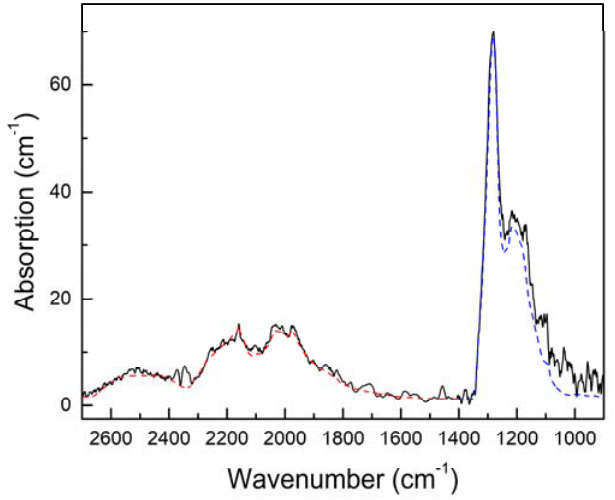
Figure 5. Infrared absorption spectrum of a spontaneous diamond aggregate from run ES-8. Red dashed curve shows standard absorption spectrum of type IIa diamond. Blue dashed curve shows absorption spectrum of A-form nitrogen.